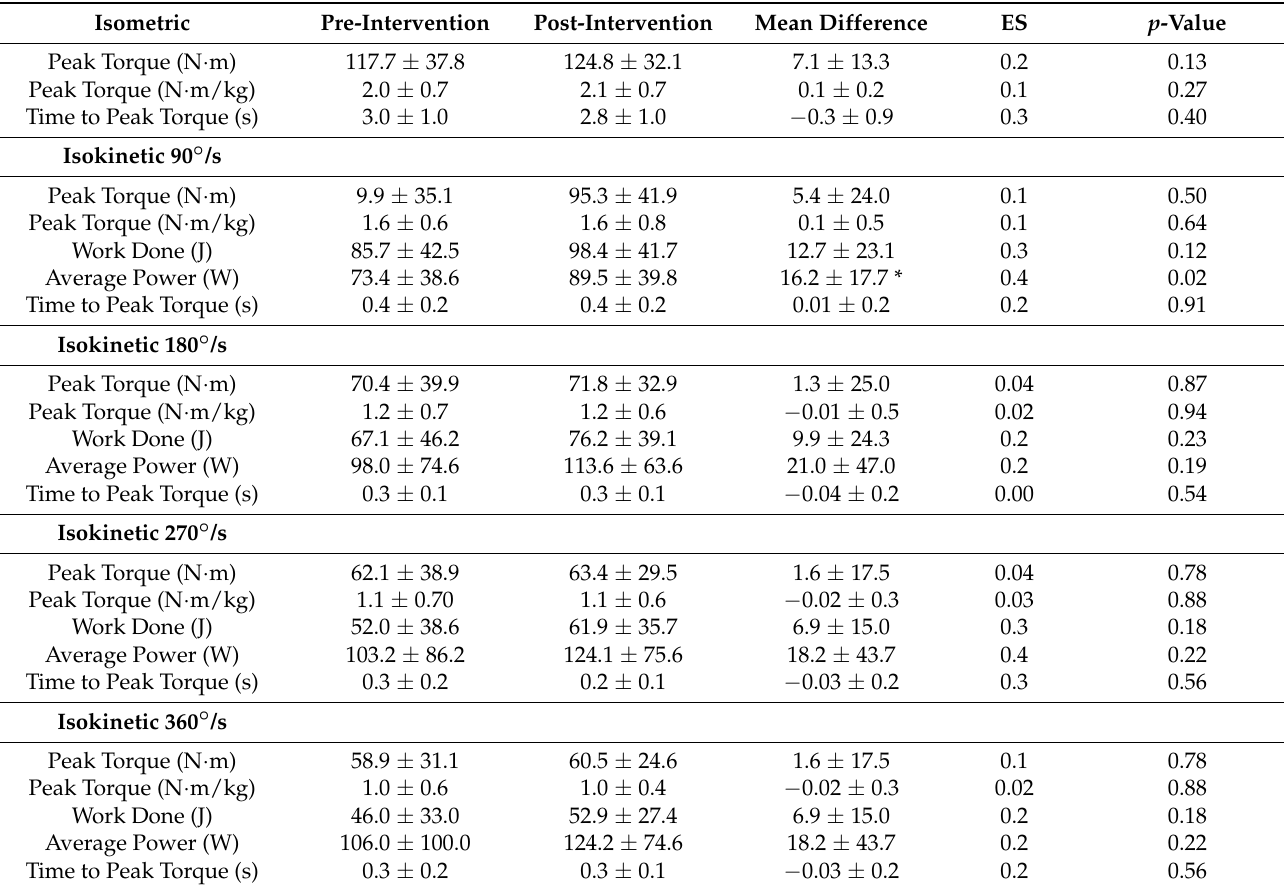
Table 5. Isometric and isokinetic knee extension test metric pre-post changes ( N = 10).